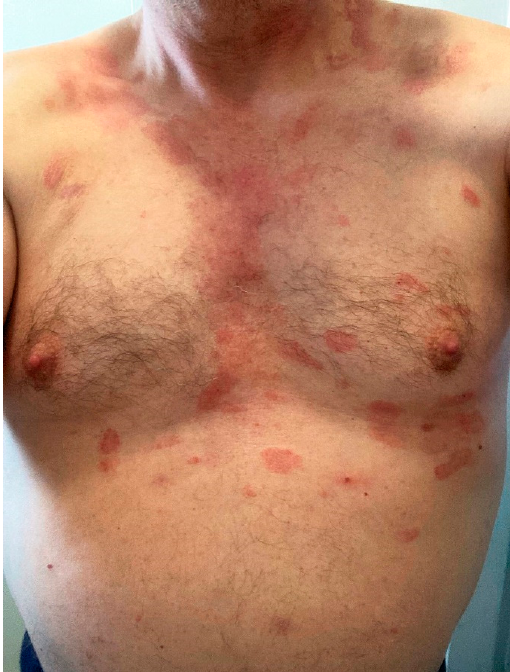
Figure 4. Pityriasis rosea-like eruption: multiple scaly, pink, or red patches developed 20 days after mRNA-1273 vaccination. Histopathology showed features of pityriasis rosea.